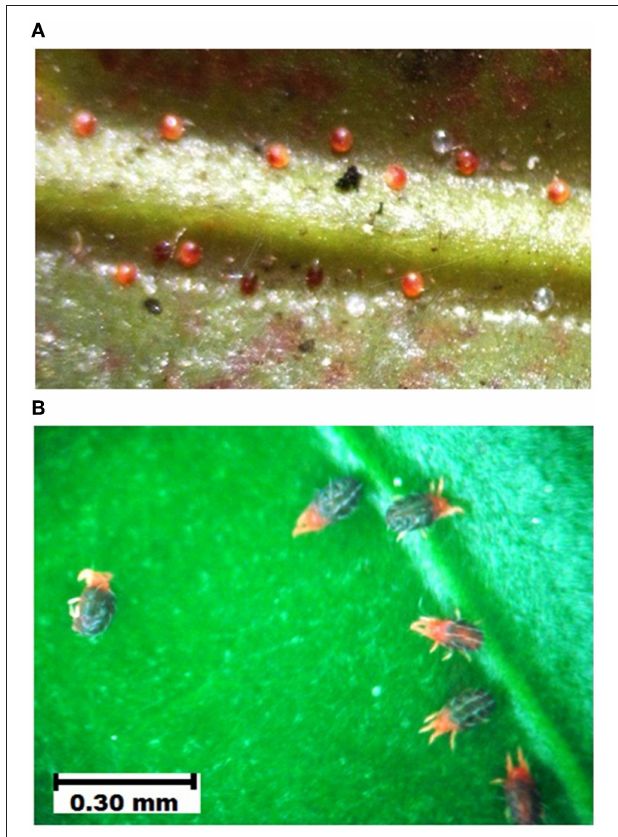
FIGURE 1 | Tea red spider mites ( A : eggs, B : adults).